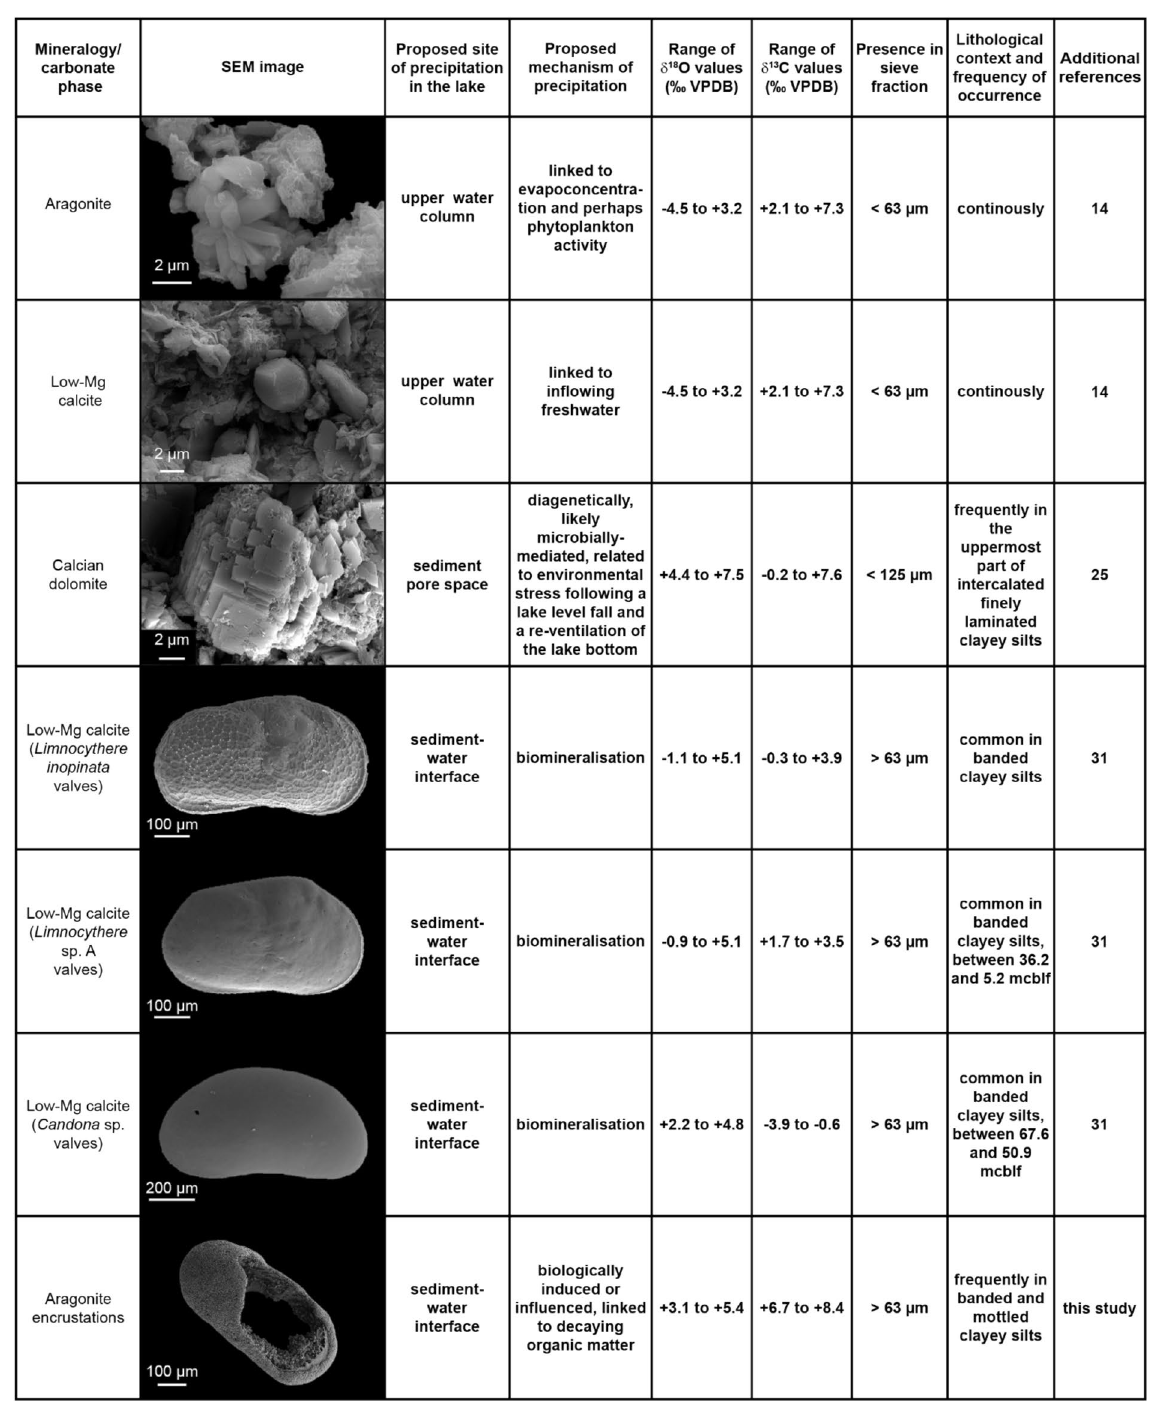
Figure 1. Variability of carbonate components in Lake Van with respective δ 18 O and δ 13 C isotope range. Note the high variability in δ 18 O and δ 13 C values between each carbonate phase. The additional references provide further information on the isotopic composition and environmental context of the individual carbonate components. SEM images of aragonite, low-Mg calcite and dolomite are from McCormack et al. 14 , images of ostracod valves are from McCormack et al. 31